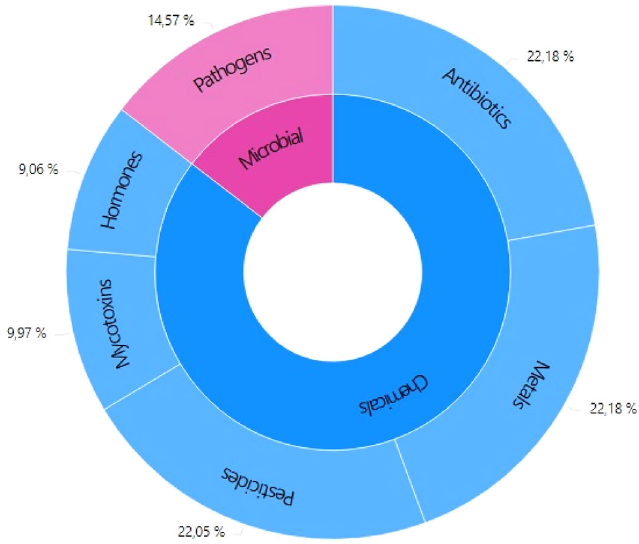
Figure 2. Distribution of literature related to contaminants in bovine milk between